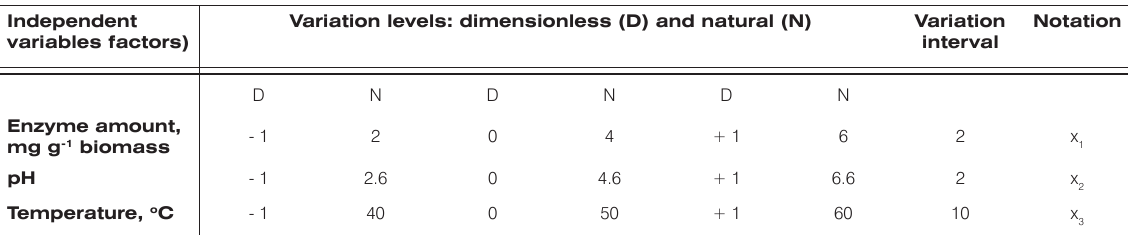
Table 1. Pretreatment process variables, central point, variation interval and levels considered. Independent Variation levels: dimensionless (D) and natural (N) variables factors)